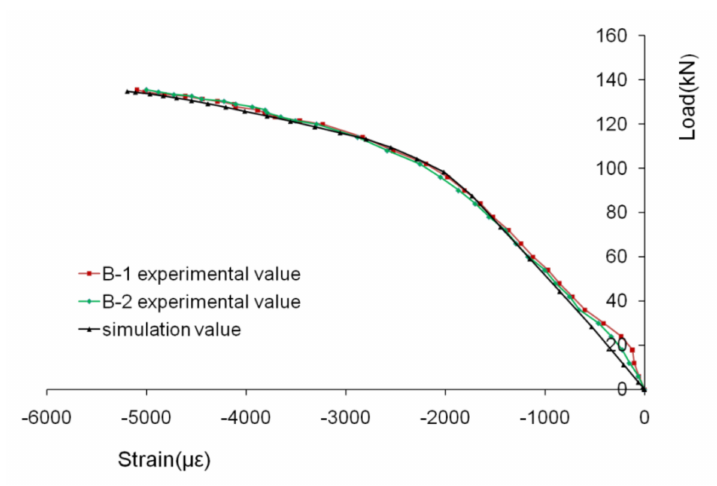
Figure 16. Comparison of load-strain curves of foam